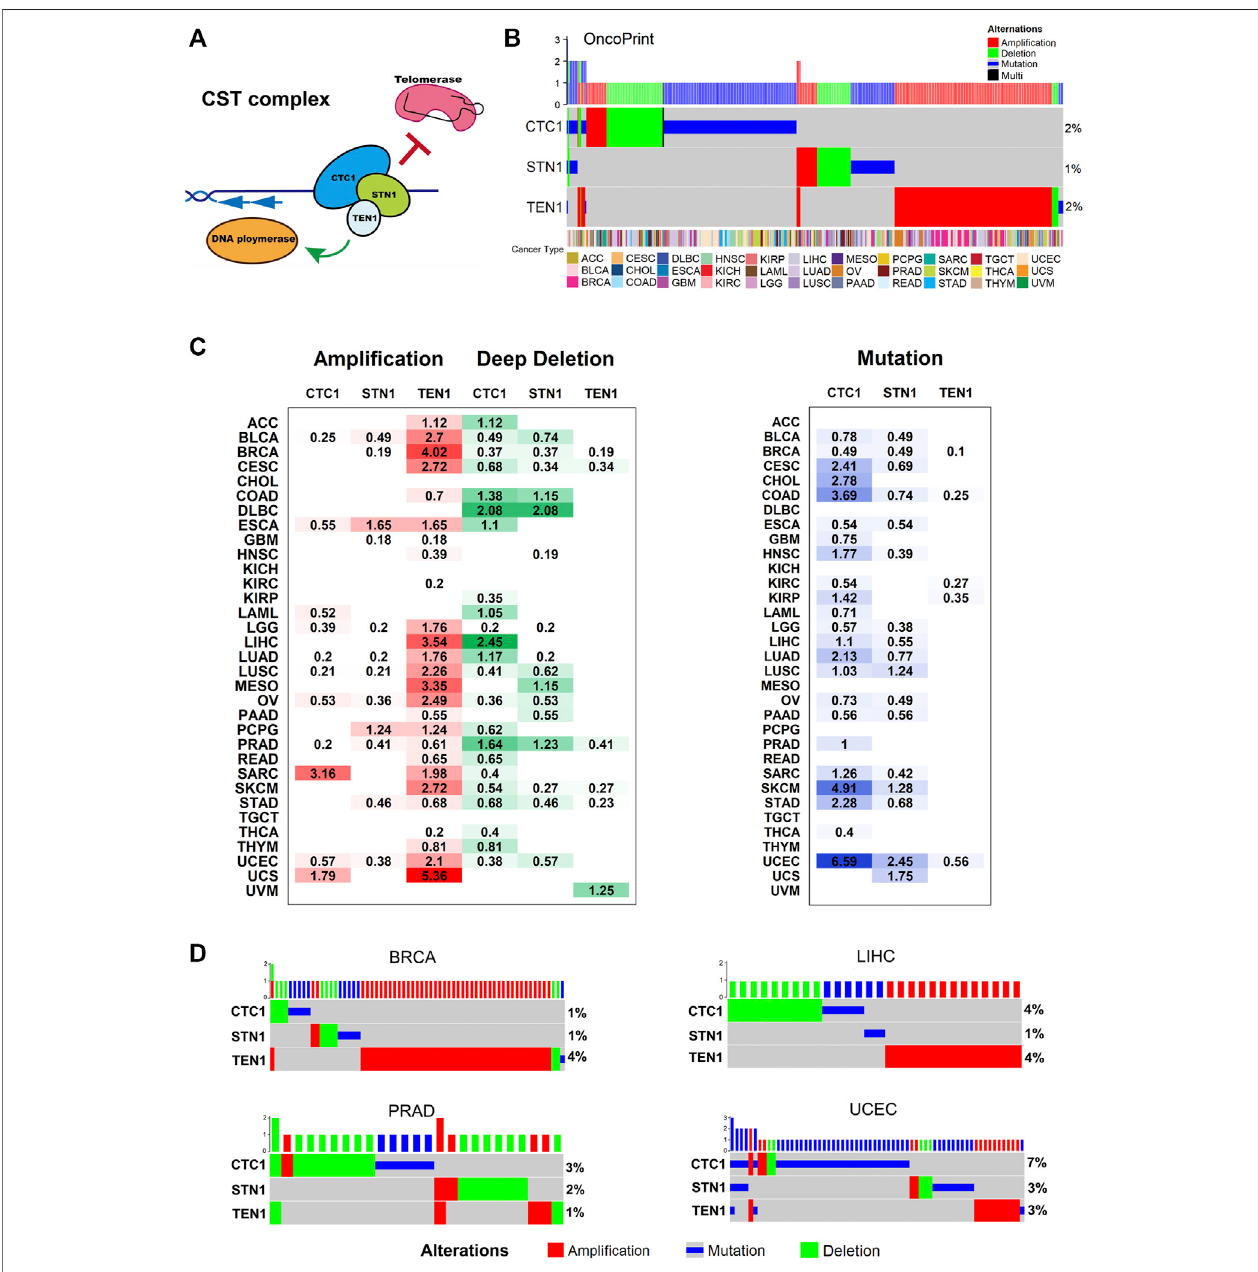
FIGURE 1 | CST complex ’ s alteration in cancer: (A) schematic of the CST complex and its telomeric DNA binding and functions. (B) Landscape of genomic aberrations (non-silent mutation, ampli fi cation, and deep deletion) in the CST genes across cancer types. Each row represents a gene, and each column represents a sample. The frequencies are calculated over the entire cohort, with only altered samples plotted. The oncoprint plot displays the overall frequency of alterations in each gene in the right labels. The cancer type is shown in the color key at the bottom. (C) Distribution of SCNA (left) and mutation (right) and frequencies over cancer types. The degree of darkness is proportional to the frequency. (D) Genomic aberrations of the CST complex genes in BRCA, LIHC, PRAD, and UCEC. Each row represents a gene, and each column represents apatient sample. Green depicts deep deletion, red depicts ampli fi cation, and blue depicts mutation. Only samples with genomic alterations in the indicated genes are shown. Alteration rates per gene are displayed in the right